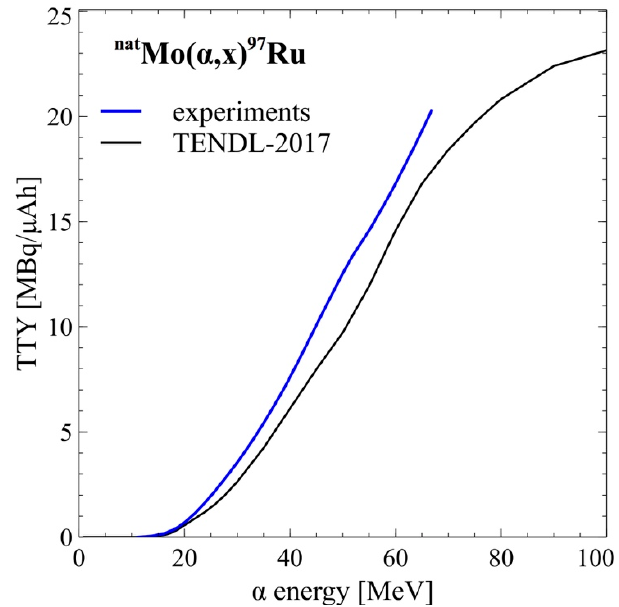
Figure 7. TTY for 97 Ru production via nat Mo( ⍺ ,x) on metallic nat Mo target. The experimental curve (blue) is calculated using the cross-section from this work (above 40 MeV) and the data provided by [3,20] below 40 MeV.